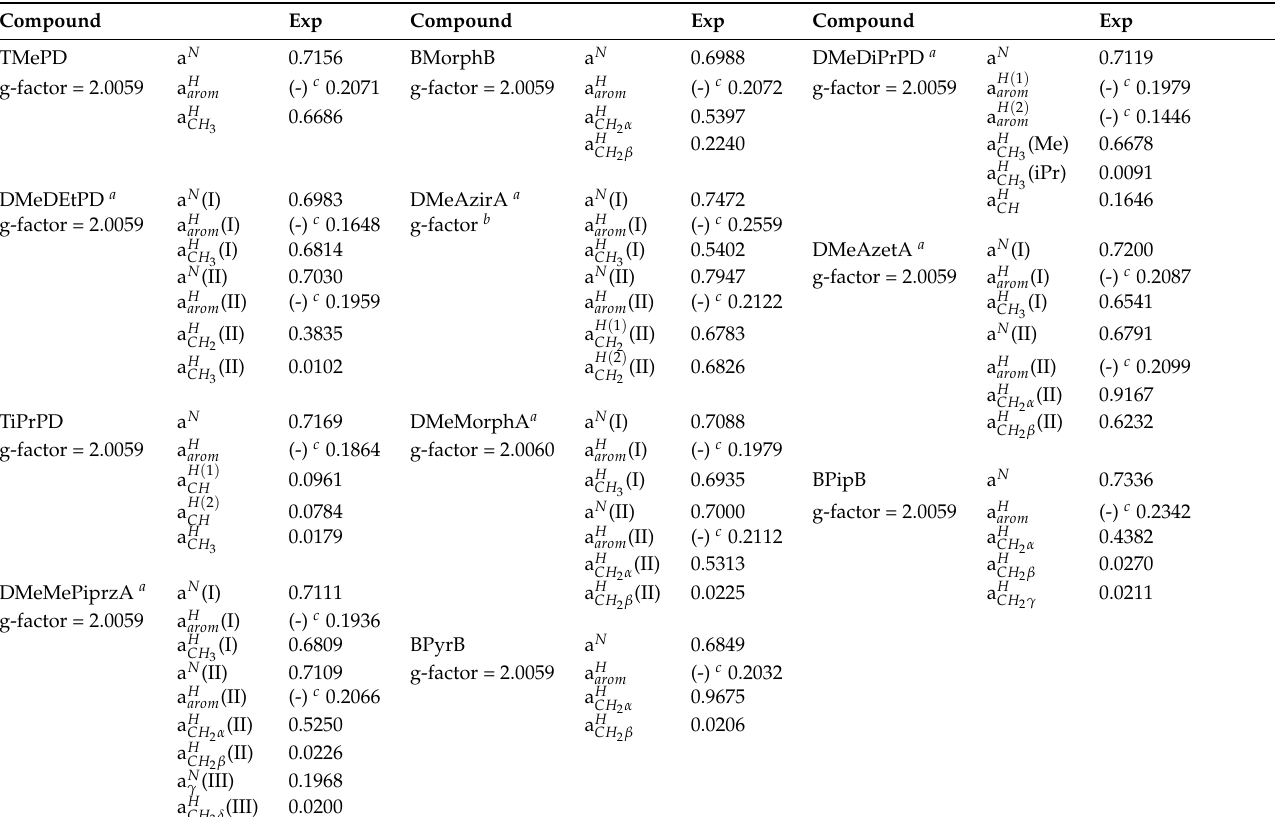
Table 2. Experimental hyperfine coupling constants (mT) determined from ESR